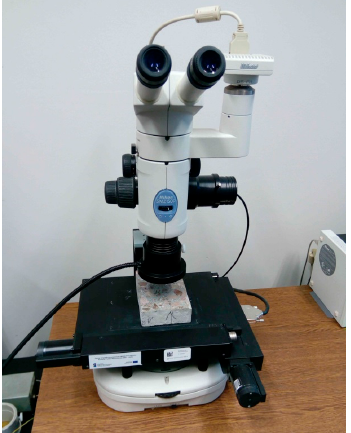
Figure 1. View of the microscope with the attachment mounted on the objective lens for additional illumination of concrete specimens. The sand and coarse aggregate particles on the image were much brighter than the cement paste that surrounded them. The particles, particularly those of sand, had a dense structure and low porosity, and reflected light rays better than the porous cement pastes producing scattered light. Making the paste darker with the use of phenolphthalein increased the contrast between the aggregate and the cement paste.